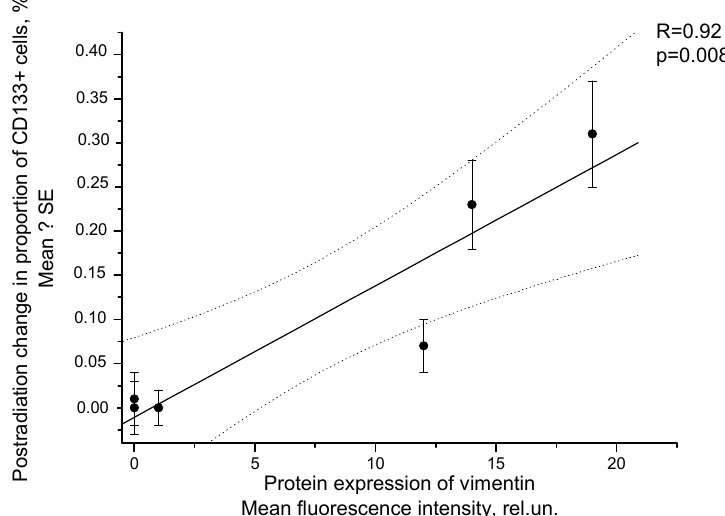
Figure 11. Correlation of postradiation changes in the proportion of CD133 + SiHa cells with protein expression of vimentin determined by flow cytometry 24 h after fractionated radiation exposure at TDs of 2–10 Gy. Vimentin expression was assessed by the fluorescence intensity of cells stained with PE-labeled antibodies to vimentin after subtracting the mean intensity of nonspecific binding in the control samples. The dotted lines indicate 95% confidence limits for linear regression (solid line).